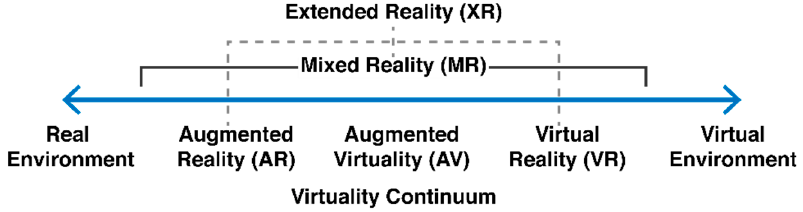
Figure 1. Adaptation of the Milgram and Kishino’s virtuality continuum [5].